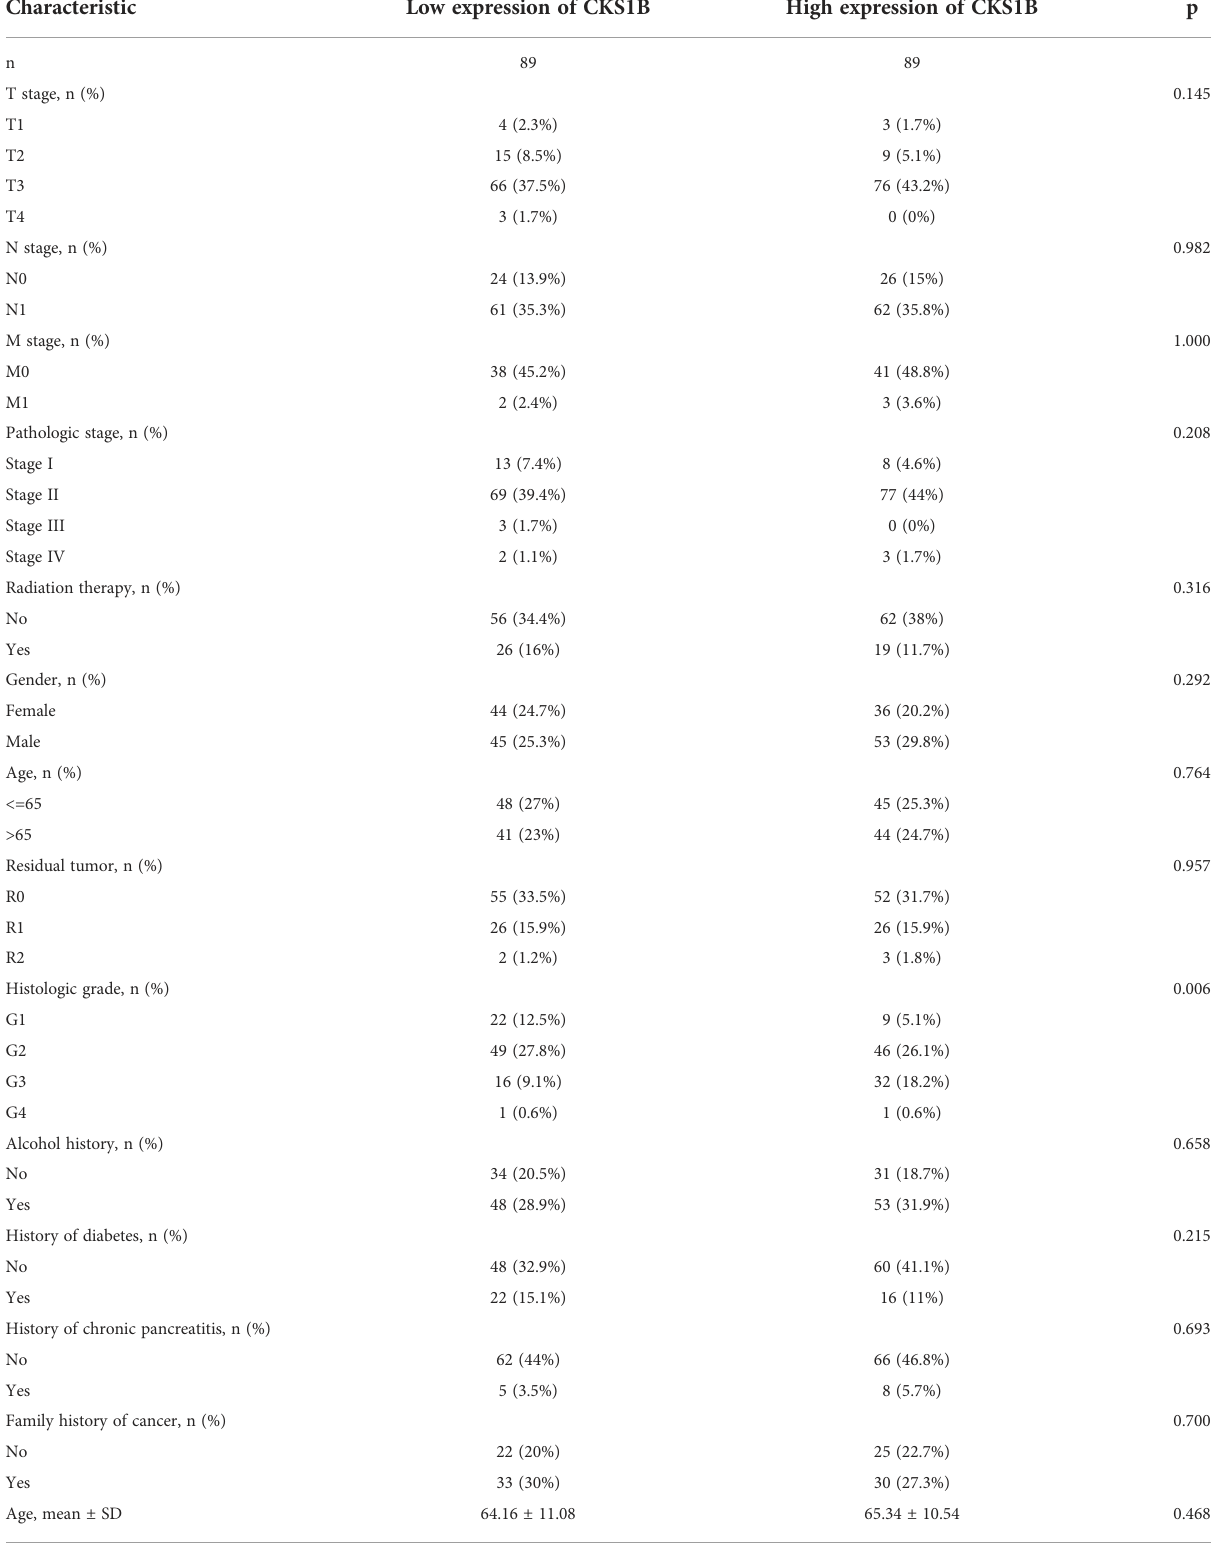
TABLE 2 The clinical characteristic between high CKS1B and low CKS1B